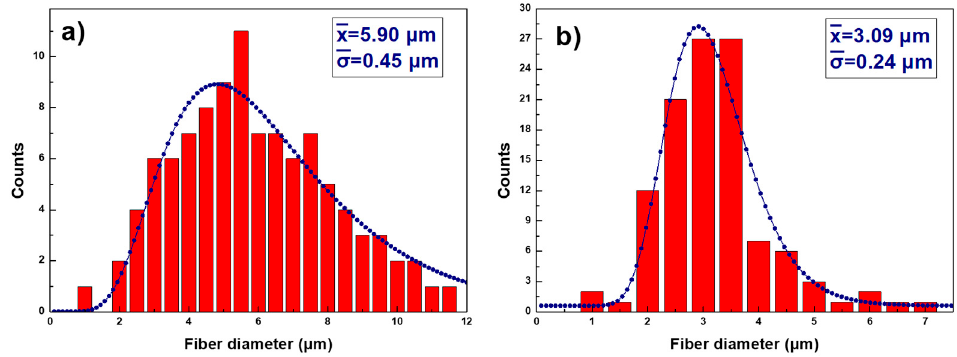
Figure 2. Histograms of the diameter distribution of the fiber samples S1 ( a ) and S2 ( b ).